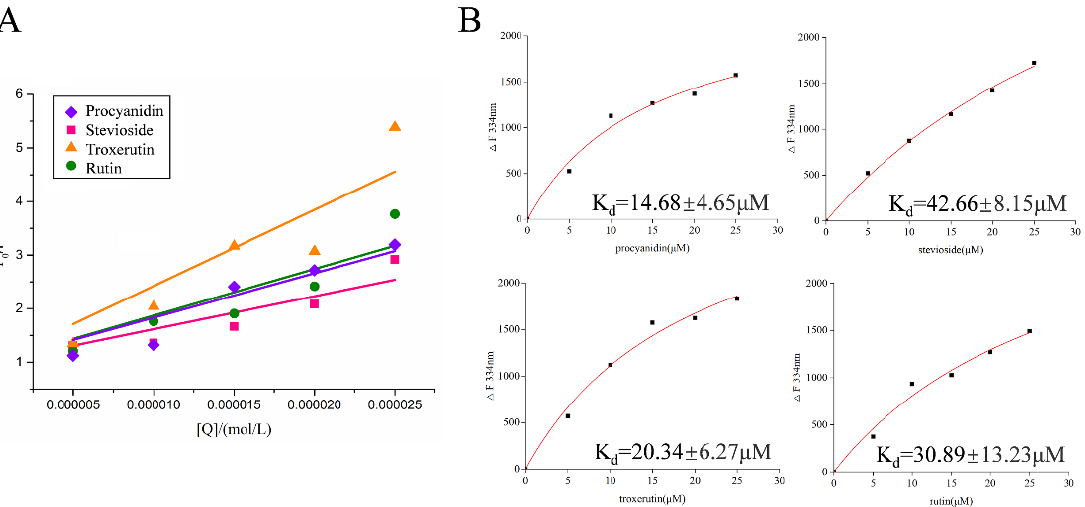
Table 2. Fluorescence quenching constants of the interaction between active compounds and LolB.